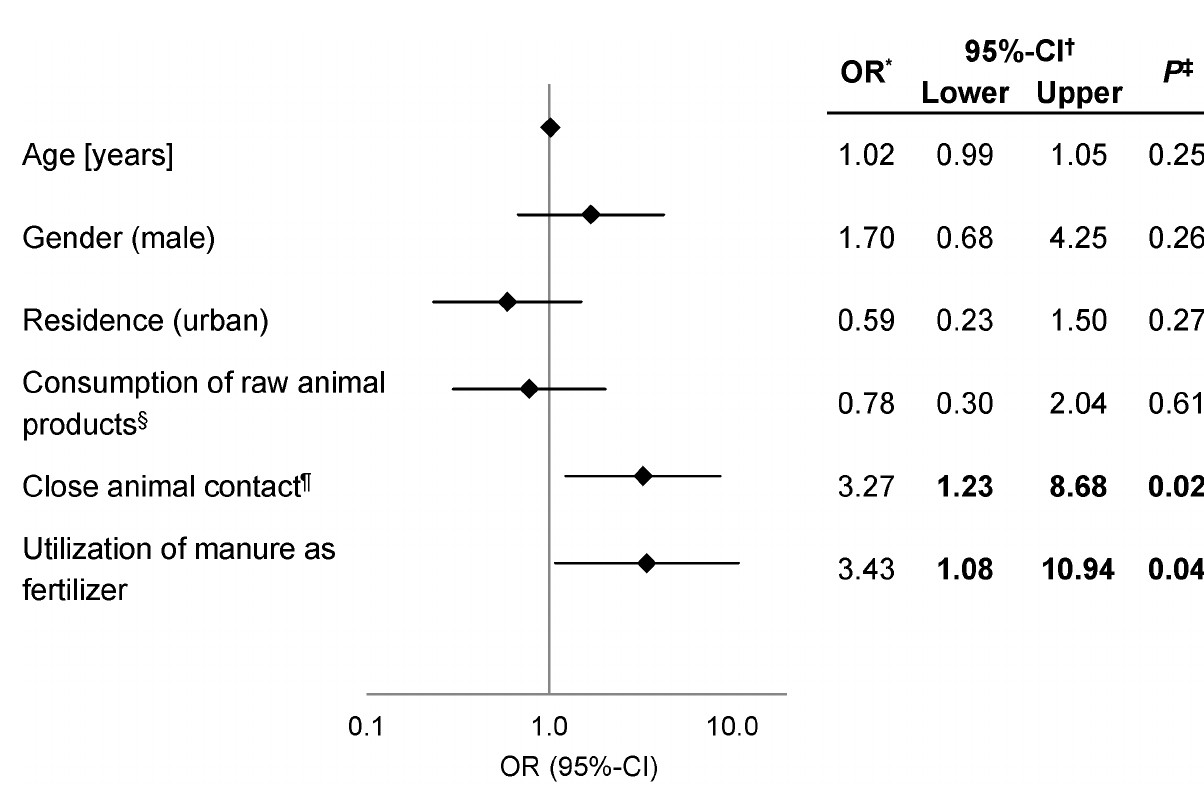
Fig 1. Binary logistic regression model of exposure factors for the colonization of the human gastrointestinal tract. Potential risk factors discussed in the literaturewere includedin the logistic regressionmodel and adjusted ORs * were calculatedwith a confidence interval(CI † ) of 95%. The x-axis is displayedlogarithmically. P -valueswere calculatedusing the chi-squaretest ( ‡ ). Results were significantif a p -values less than 0.05 was detected or the 95%-CI does not include1 and were indicatedin bold . § raw minced meat, raw milk and raw milk products; ¶ Contact with excrement or saliva of animals, striking of